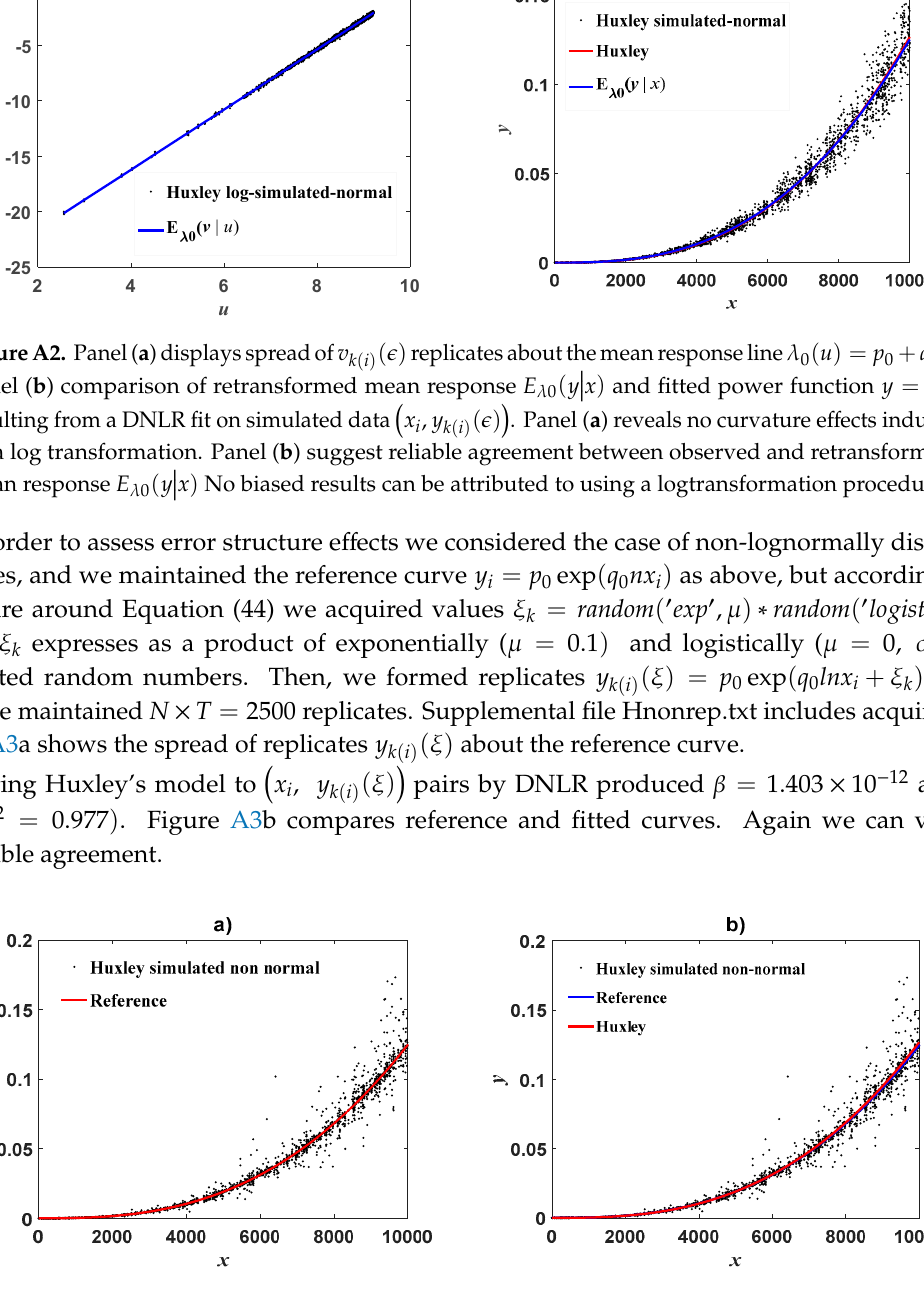
Figure A3. Huxley’s model fitted by DNLR on simulated non–normally distributed data. Panel ( a ) spread of y k ( i ) ( ξ ) values about reference curve y i = p 0 exp ( q 0 lnx i ) Panel ( b ) comparison of reference curve and mean response y = β x α fitted by a DNLR protocol.